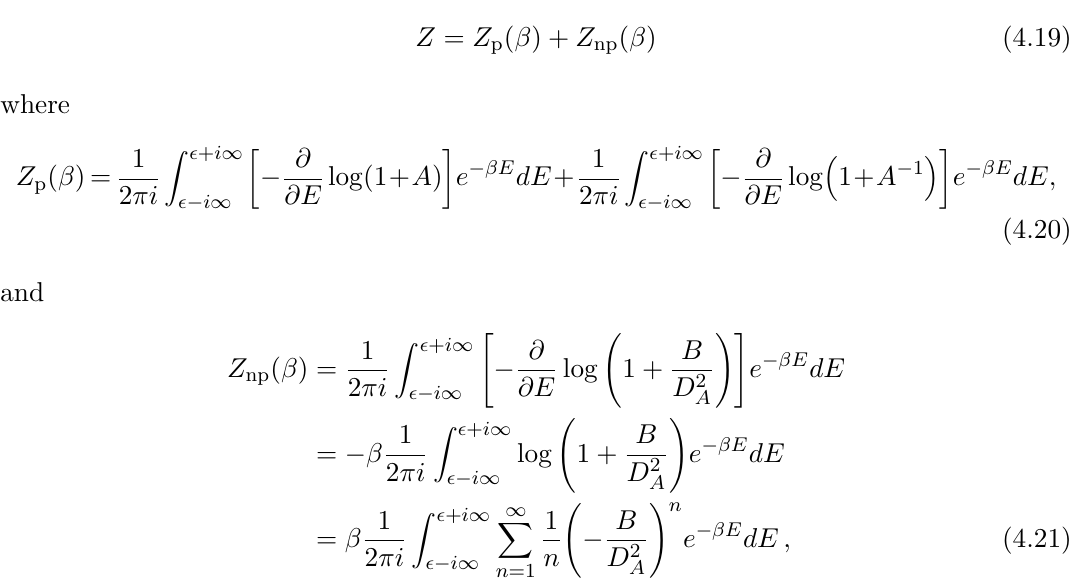
B in eq. (4.17), as a unit. D − 2 A = 1 ) and one B -cycle ( B A 1+ A